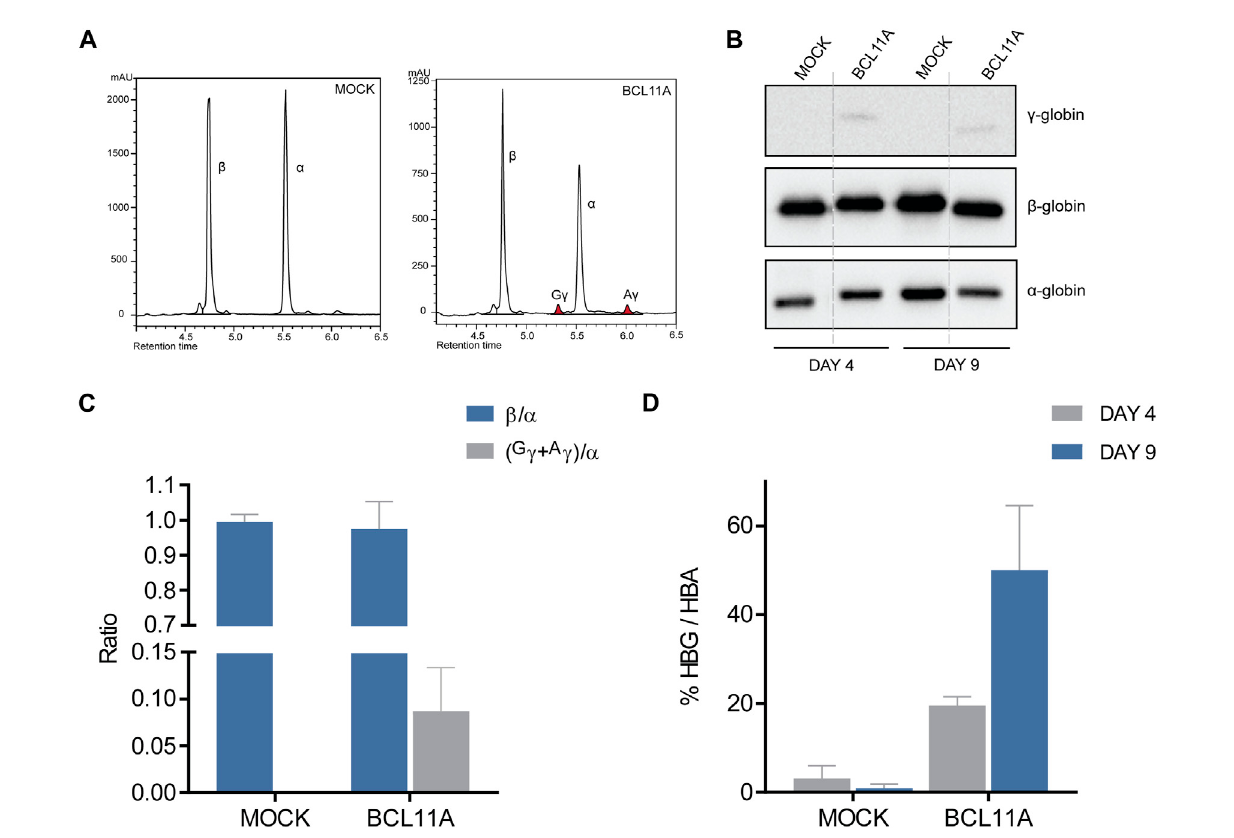
FIGURE 3 Functional analysis of BE-modi fi ed HUDEP-2 cells. (A) Chromatograms of HPLC analysis for the BCL11A and mock targeting at the last day of HUDEP-2 erythroid differentiation, with the peaks showing globin expression. The α -, β - and γ -globin peaks are labelled, and colored peaks indicate γ - globininduction. (B) ImmunoblotsoftheeditedHUDEP-2 cellsondays4and9oferythroiddifferentiation,detecting theproteinexpressionof α -, β -and γ -globin. Dashed lines indicate where images were simpli fi ed by removal of surplus lanes (see Supplementary Figure 2 for the full image). (C) Quanti fi cation of HPLC analysis in a chart showing the globin ratios of β / α and ( G γ + A γ )/ α . Data are plotted as mean ± s.d. ( n = 2). (D) Quanti fi cation of immunoblots in a chart showing the % of ( G γ + A γ )/ α expression in each target on days 4 and 9 of erythroid differentiation. Data are plotted as mean ± s.d. ( n =